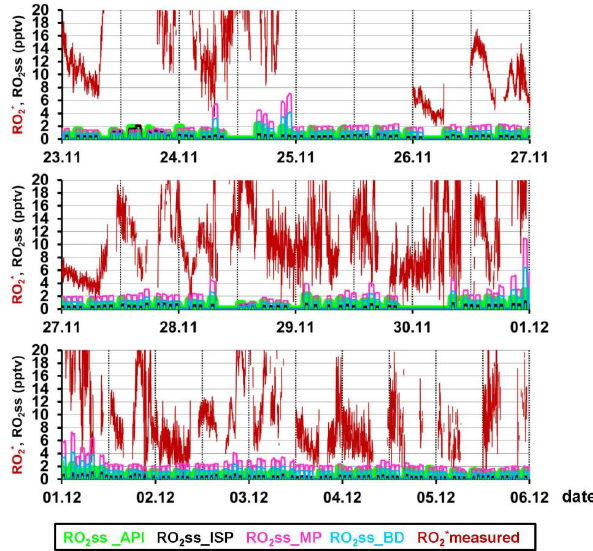
Fig. 11. Comparison between measured RO 2* and calculated RO 2 ss from ozonolysis of different alkenes: API:α-pinene; ISP: isoprene; BD: butadiene, and MP: methylpentene.